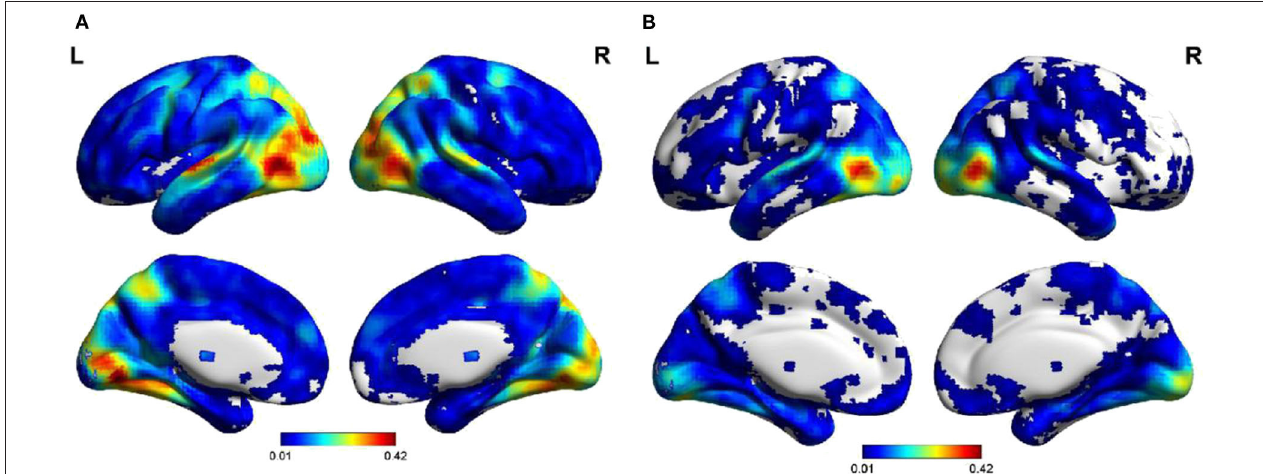
FIGURE 5 | (A) Arousal in brain regions while watching Psycho clip. (B) Arousal in brain regions while watching street scene clip. The colors indicate areas of consistent brain activity and the closer the color to red, the higher the activity’s consistency.